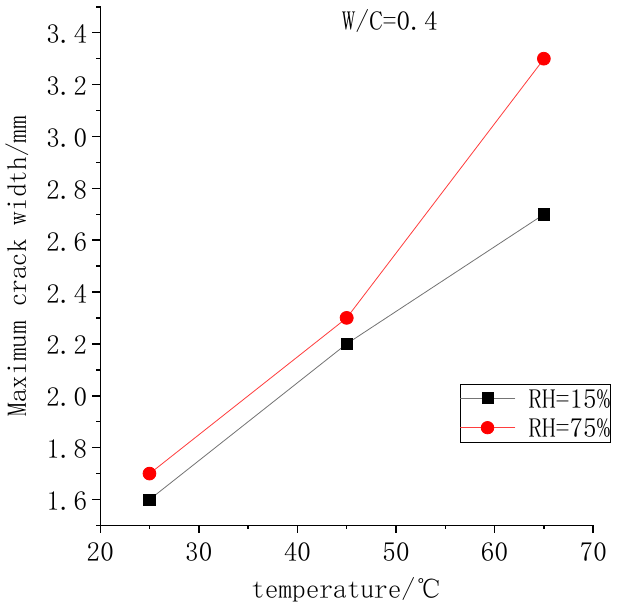
Figure 11. Maximum crack width of foamed concrete under different curing environments.